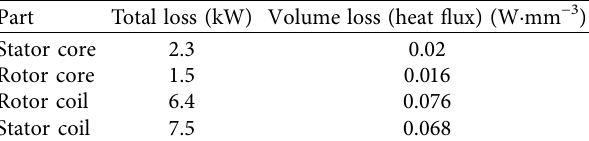
Table 3: Te losses of each component of traction motor.